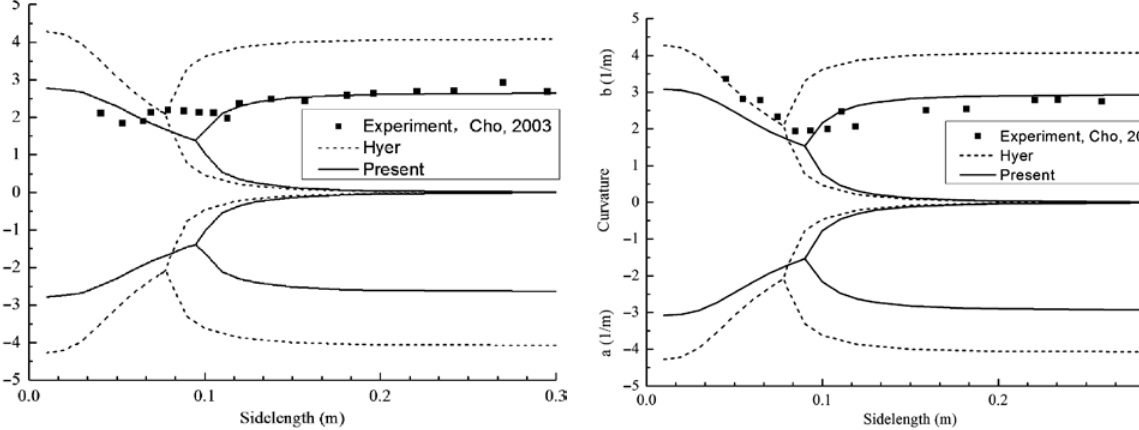
Figure 7: Change of curvature as a function of the side length for [0 /90 ] laminate for the Al tool. 4 4 T